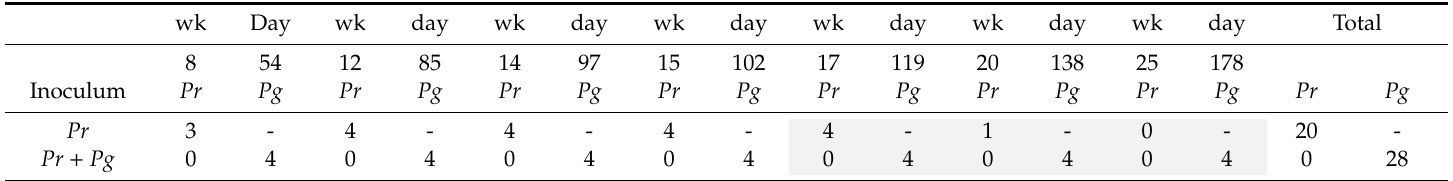
Table 3. Count of P. ramorum ( Pr ) and P. gonapodyides ( Pg ) recovery from single leaf disc baits deployed for three to seven days in a total of four microcosms per treatment (i.e., out of four possible colonization events per sampling, 28 in total. Dash indicates not inoculated and not recovered) with sterile water only in the yellow leaf experiment. Grey shading indicates results when all leaves had been removed from the microcosms (116